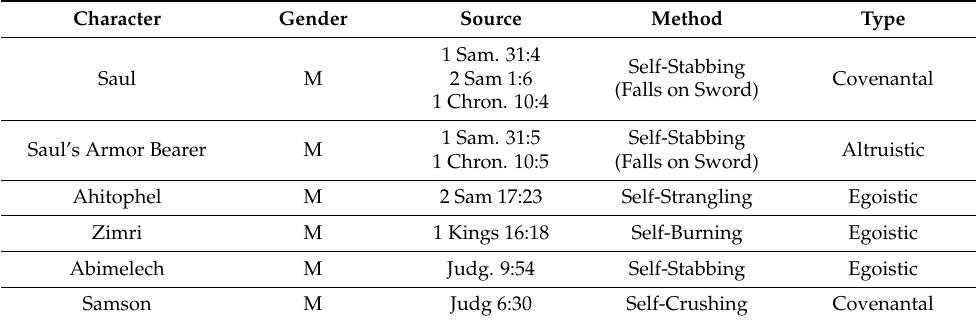
Table 2. Suicides in the Hebrew